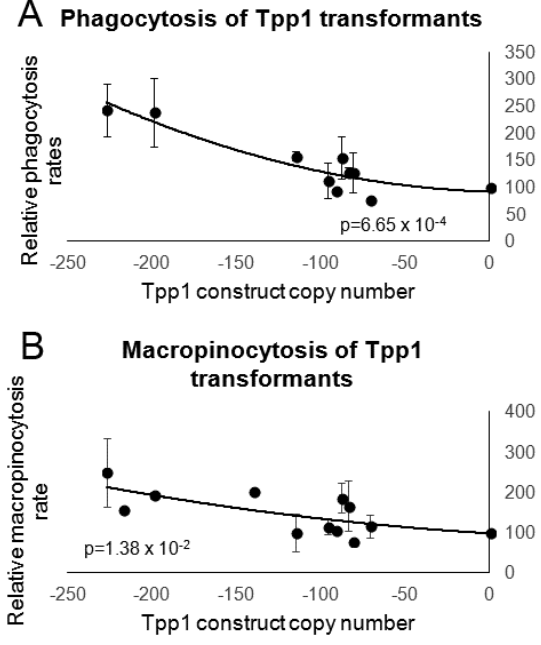
Figure 5. Reduction of Tpp1 increases endocytosis. ( A ) The ability of wild type and Tpp1 mutant cells to ingest a fluorescently labelled bacterium (DsRed-expressing E. coli ) was measured and results were normalised to wild type. The data show that reduced levels of Tpp1 expression result in increased rates of bacterial uptake. Cell lines were measured in at least three independent experiments and error bars represent standard deviations. ( B ) Wild type and Tpp1 mutant cells were resuspended to a density of 1 × 10 7 cells · mL − 1 and allowed to take up HL-5 medium containing the fluorescent marker FITC-dextran. Aliquots were removed at specific time points, washed and lysed to release cell contents. Fluorescence was then measured using a fluorometer and values were normalised against the wild type. Cell lines were measured in at least three independent experiments and error bars represent standard deviations. Regressions were significant at indicated p values (t test). Both lines were fitted by the least squares method to an exponential equation.